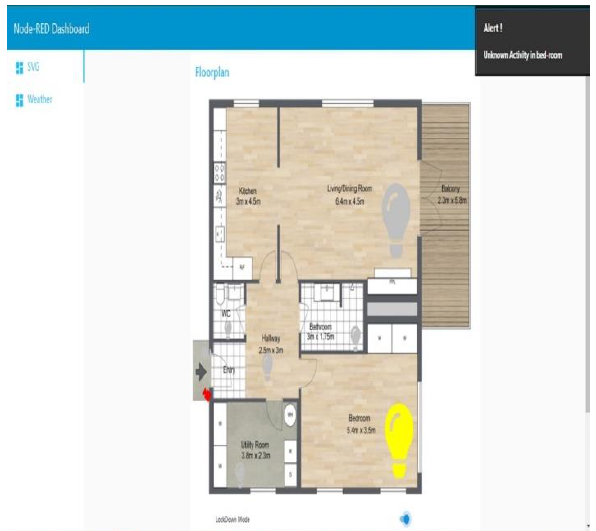
Fig.6 . House Plan Showing all devices when Lockdown Mode